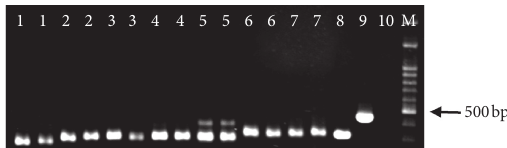
Figure 2: PCR product electrophoresis for ITS1 fragments of Leishmania from VL patients on 1.5% agarose gel. Lane 1–7 (in duplicate): Leishmania isolated from VL patients; 8: L. infantum positive control; 9: L. tropica positive control; 10: negative control; and M: 1 kb molecular weight